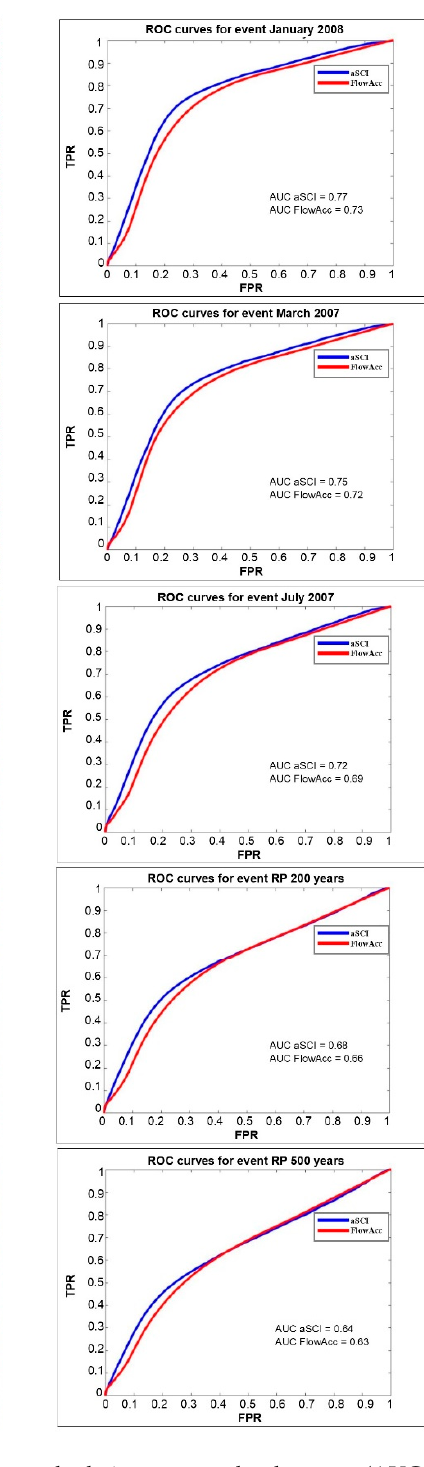
Figure 7. Receiver operating characteristic (ROC) curves and relative areas under the curve (AUCs) of a-SCI and flow accumulation (FA) maps performance in test area. ( a – c ) Flooded area (blue-bordered region, on the left) during observed flood events and corresponding ROC curves of a-SCI and FA maps (blue and red curves respectively, on the right). ( d , e ) Flooded area (blue-bordered region, on the left) in predicted flood events and corresponding ROC curves of a-SCI and FA maps (blue and red curves respectively, on the right).